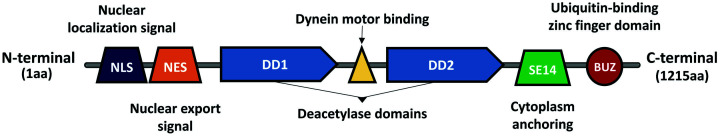
Histone deacetylase 6 (HDAC6) structure and domains. HDAC6 is a Class II histone deacetylase, composed of 1,215 amino acids. It is the only member from the Class II deacetylases containing two active catalytic domains (DD1 and DD2), which allow it to interact with different substrates (e.g., α-tubulin, HSP90, cortactin, et cetera). Due to the nuclear localization signal (NLS) and the nuclear export signal (NES), HDAC6 can shuttle between the nucleus and cytoplasm, however, the presence of a cytoplasm anchoring domain (SE14) ensures that HDAC6 is stably present in the cytoplasm. Between DD1 and DD2 exists a dynein motor binding domain, which allows HDAC6 to interact with the dynein motor complex and modulate cargo trafficking alongside the microtubules. In the C-terminal exists a ubiquitin-binding zinc finger domain (BUZ) with a high affinity to poly-ubiquitinated protein chains.